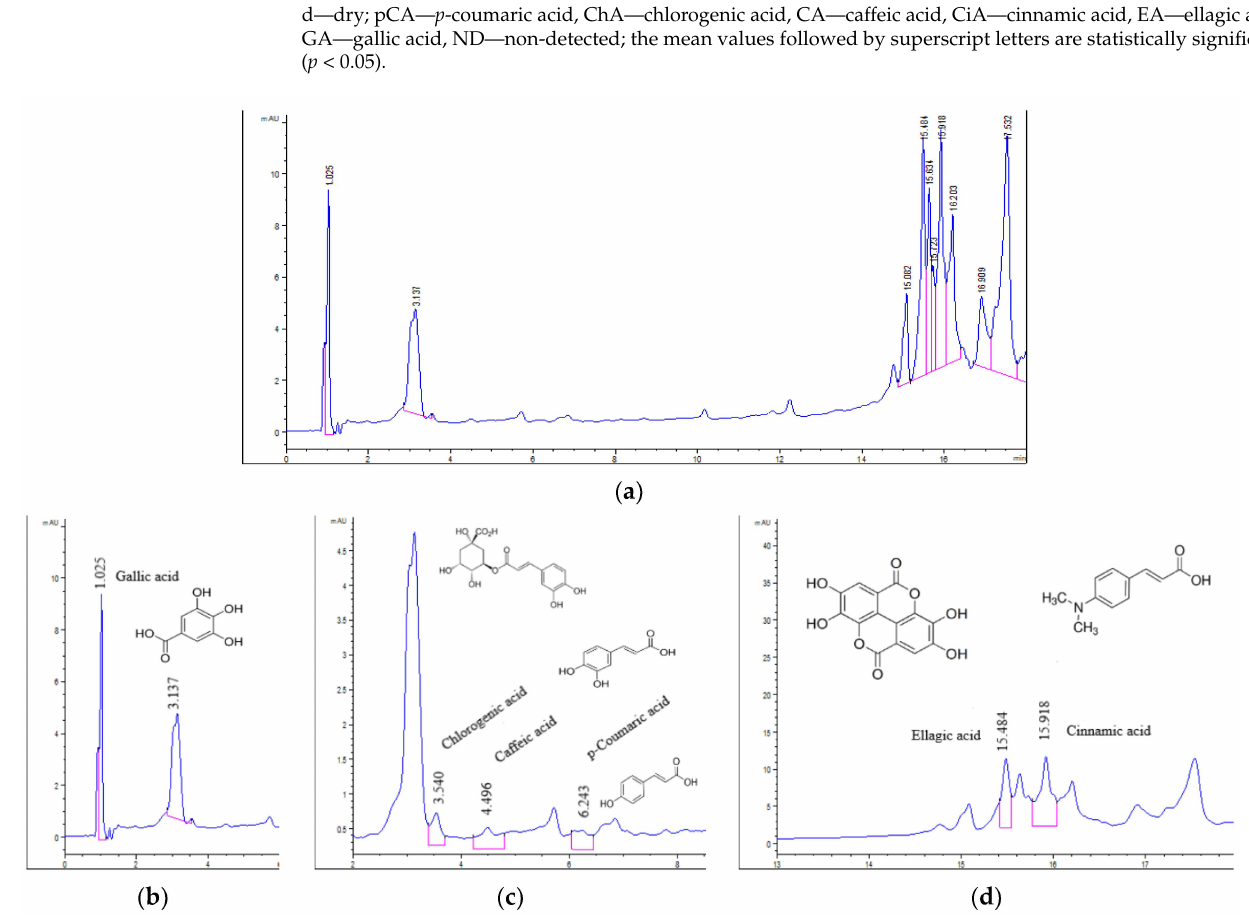
Figure 2. Chromatograms of m UBE ( a ); polyphenols in m UBE: gallic acid ( b ); chlorogenic, caffeic, and p -coumaric acids ( c ); ellagic and cinnamic acids ( d ). The red lines mark the significant peak areas, UBE— U. barbata ethanol extract, m